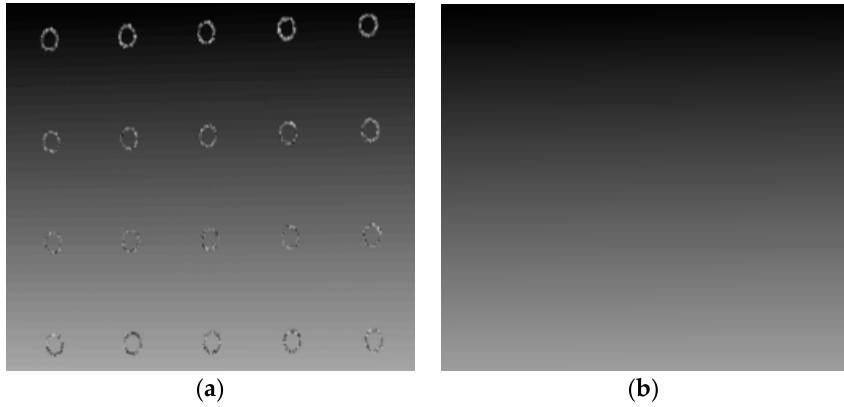
Figure 3. Absolute phase on the mirror surface for a horizontal fringe pattern: ( a ) absolute map with inaccurate phase data for the hollow ring markers and ( b ) absolute map processed with a 3D surface fitting algorithm.